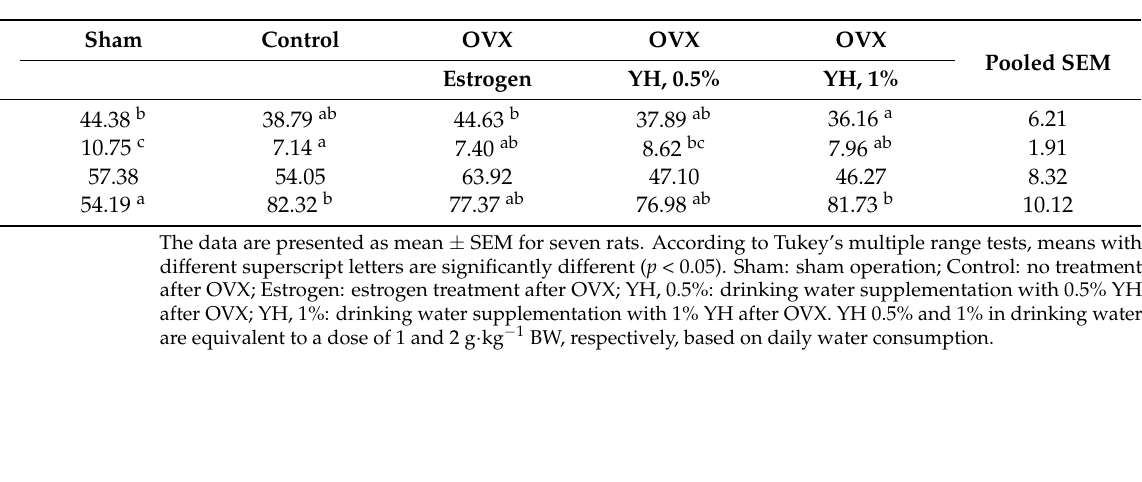
Figure 3. Serum biomarkers of bone metabolism of ovariectomized (OVX) rats treated with yeast hydrolysate (YH) for 8 weeks. The data are presented as mean ± SEM for seven rats. According to Tukey’s multiple range tests, means with different superscript letters are significantly different ( p < 0.05). ( A ): calcium; ( B ): alkaline phosphatase (ALP); ( C ): osteocalcin; ( D ): cross-linked telopeptide of type I collagen (CTx). Sham: sham operation; Control: no treatment after OVX; Estrogen: estrogen treatment after OVX; YH, 0.5%: drinking water supplementation with 0.5% YH after OVX; YH, 1%: drinking water supplementation with 1% YH after OVX. YH 0.5% and 1% in drinking water are equivalent to a dose of 1 and 2 g · kg − 1 BW, respectively, based on daily water consumption. The trabecular bone microarchitecture according to μ -CT is shown in Table 1. No significant differences in BV/TV and Tb.Th were observed between OVX and sham-operated rats. Estrogen and YH treatment of OVX rats improved BV/TV, Tb.N, and Tb.Sp, without any statistical significance. Table 1. Trabecular bone microarchitecture of ovariectomized (OVX) rats treated with yeast hydrolysate (YH) for 8 weeks.